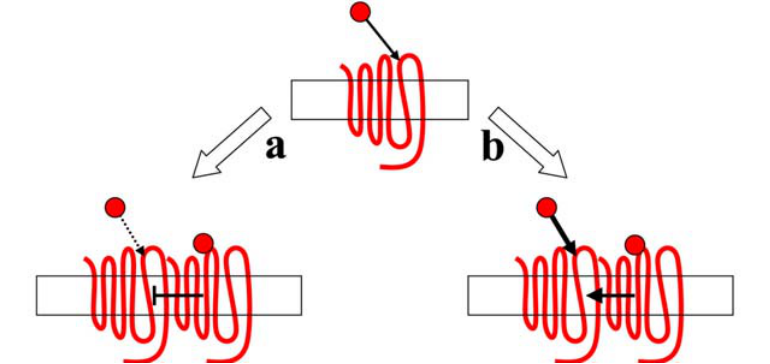
FIGURE 2. Intermolecular interactions in the receptor homodimer. The affinity of a given ligand for its receptor (central drawing) may be decreased (a) or increased (b) when the ligand already occupies the receptor partner (in the